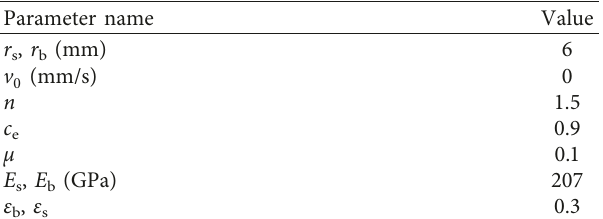
Figure 5: Displacement and velocity curves of the moving contact. (a) Displacement. (b) Table 2: Dynamic simulation parameters.